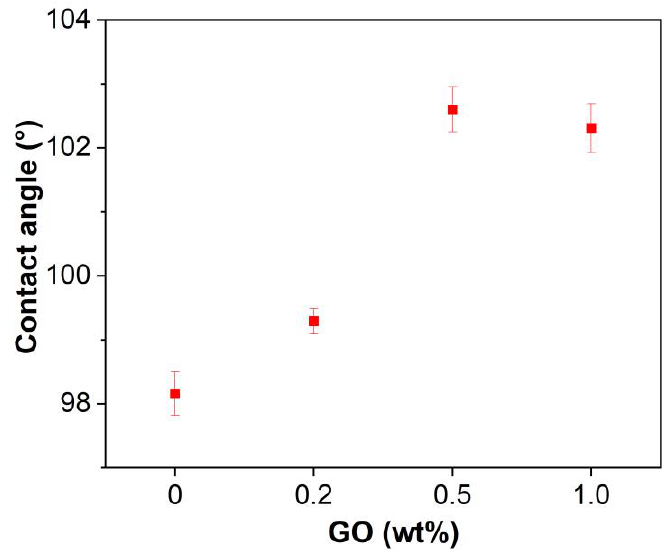
Figure 5. Contact angles of the unmodified and GO-modified EABCs.